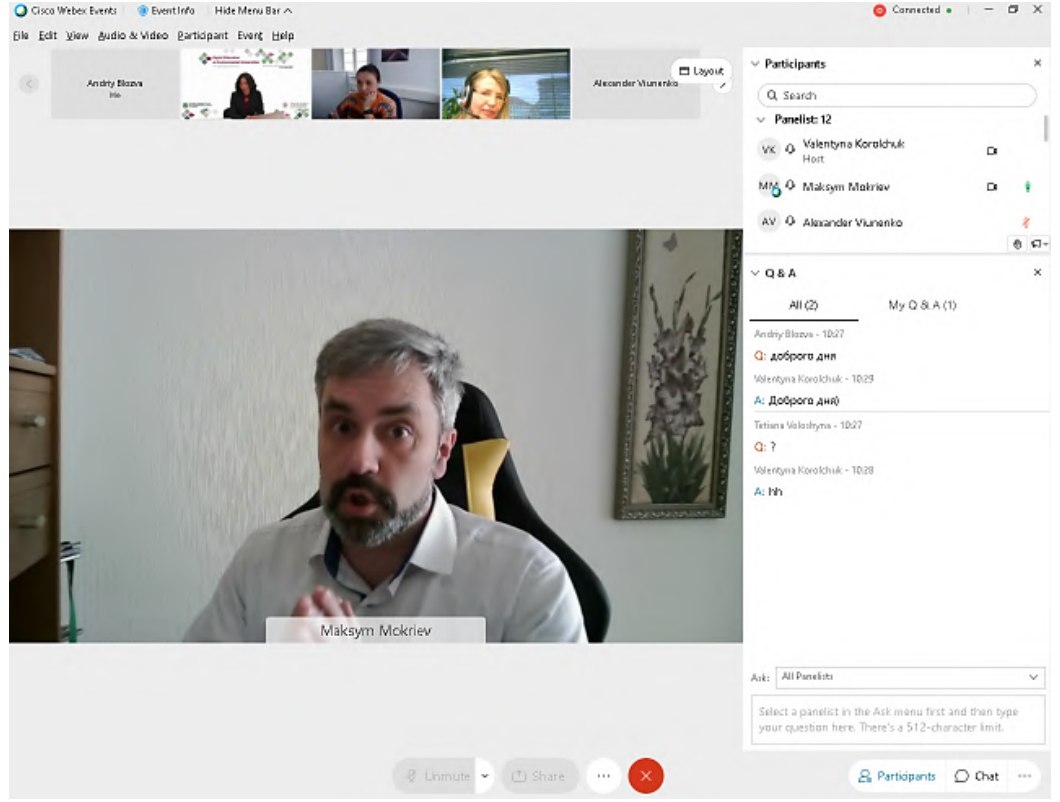
Figure 18: Presentation of paper